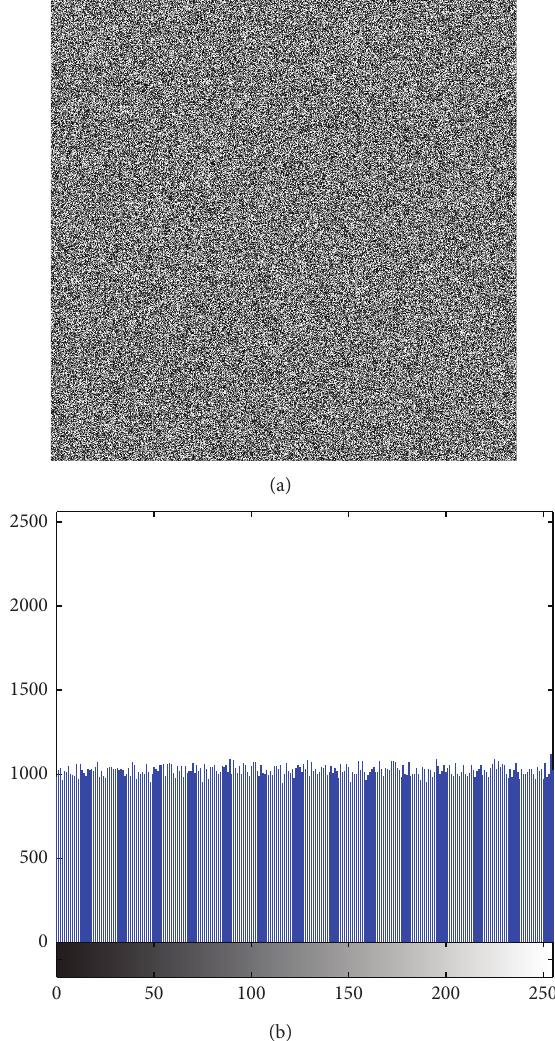
Figure 8: (a) Encrypted image and (b) its